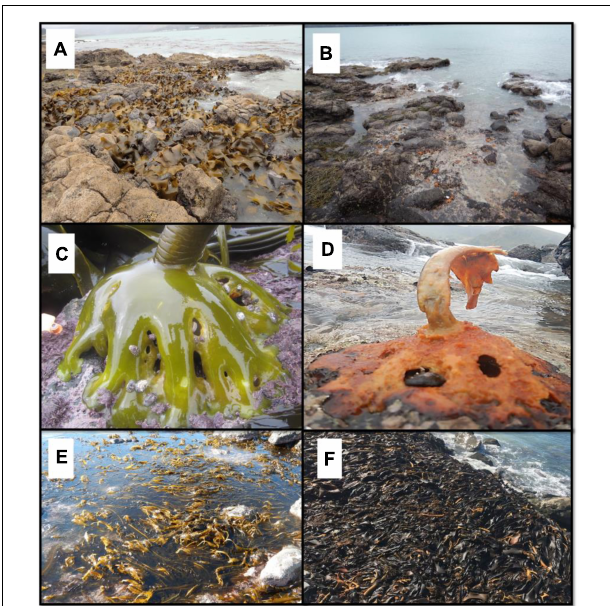
FIGURE 1 | (A) Durvillaea poha bed in Pile Bay, November 2017. (B) The same area in March 2018 where only remnants of holdfasts are visible. (C) Healthy bull kelp holdfasts inhabited by Siphonaria limpets, November 2017. (D) Decaying bull kelp in March 2018 (“ghost holdfast”). (E) Undaria pinnatifida in high densities invaded the lower parts of the reef shown in (A,B) in May 2018. (F) Large wrack accumulation of D. willana observed on many reefs after the marine heatwave (photo near Oaro, southern New Zealand).